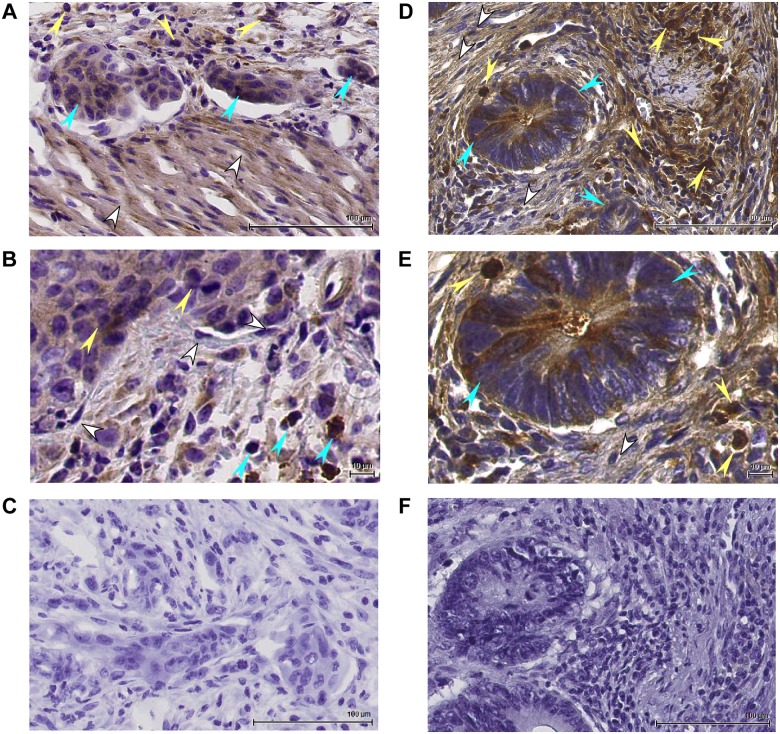
MMP9 expression in human CRC and in an orthotopic xenograft mouse model of CRC.IHC analysis of HCT116-derived xenograft tumors (A, B) or of human CRC tumors (D, E). MMP9 staining from various cellular sources is highlighted as follows: blue arrows, tumor cells; yellow arrows, inflammatory cells; white arrows, stromal cells such as fibroblasts or smooth muscle cells. (A, B) Immunohistochemical staining for MMP9 in HCT116-derived tumors at 200x (A) or 400x (B) magnification. (D, E) Immunohistochemical staining for MMP9 in a human colorectal carcinoma at 200x (D) or 400x (E) magnification. Panels C (HCT116-derived tumors) and F (human CRC) show tissue sections that were incubated with secondary antibody only and demonstrate the absence of non-specific secondary antibody binding (200x magnification).